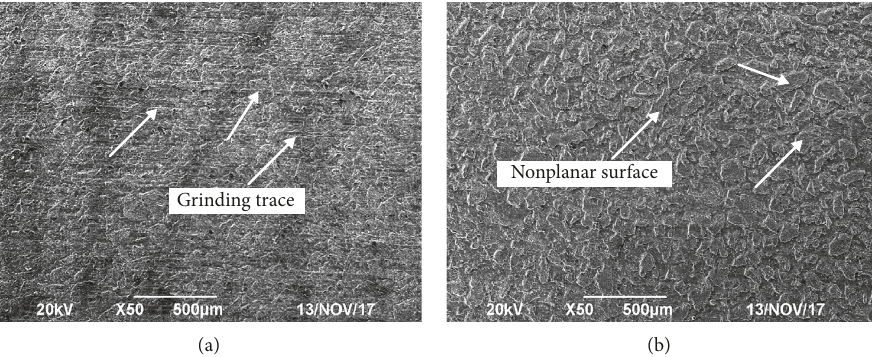
Figure 11: The fracture surface of the joint brazed at different temperatures: (a) 382 ° C; (b) 392 °